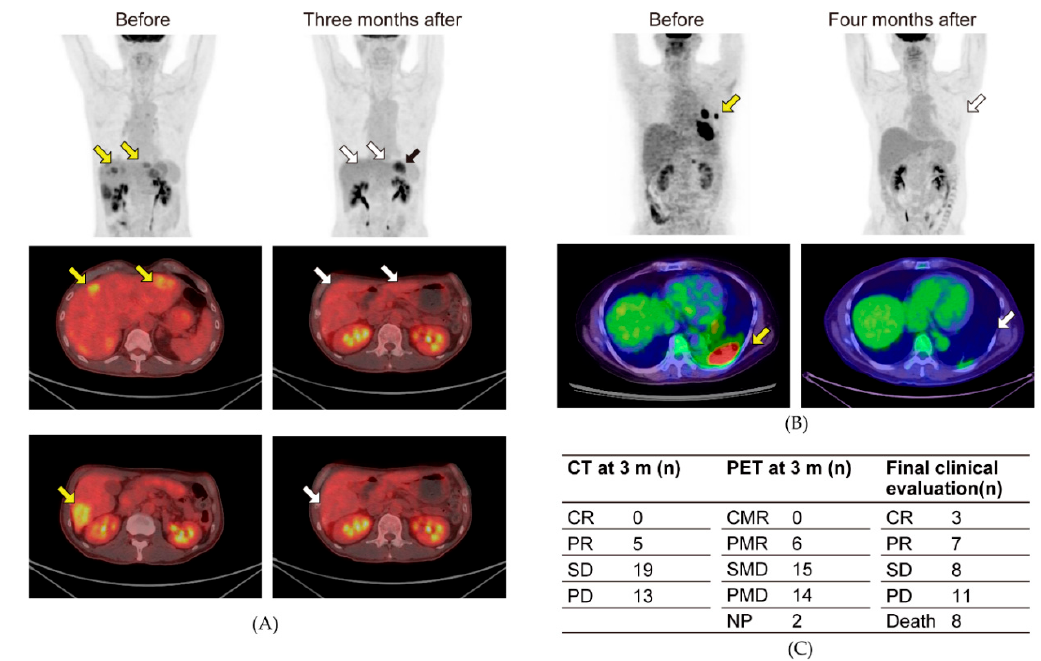
Figure 4. Clinical effect of the ketogenic diet for patients with cancer. Whole body maximal intensity projection images and axial fused PET/CT images before and after the ketogenic diet. ( A ) A 58-year-old man with colorectal cancer. ( B ) A 55-year-old man with lung cancer. Hot spots of 18F-FDG before (yellow arrow) and the same position after the ketogenic diet (white arrow). Physiological hot spot in the stomach (black arrow). ( C ) Response evaluation after the ketogenic diet. Response evaluation with PET/CT at 3 months and clinical evaluation at one year. CT imaging findings were assessed using Response Evaluation Criteria in Solid Tumors (RECIST) version 1.1. CR, complete response; NP, not performed; PD, progressive disease; PR, partial response; SD, stable disease. PET imaging findings were analyzed according to European Organization for Research and Treatment of Cancer (EORTC) criteria. CMR, complete metabolic response; PMR, partial metabolic response; SMD, stable metabolic disease; PMD, progressive metabolic disease.